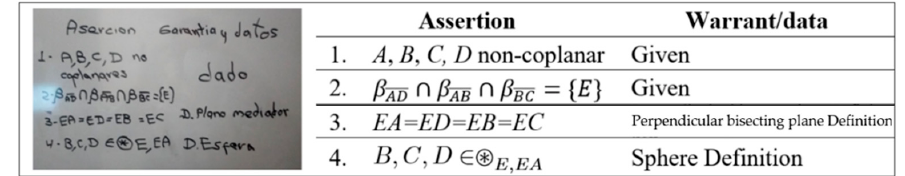
Figure 10. Dynamic diagram of problem 2 solution in 3D domain.